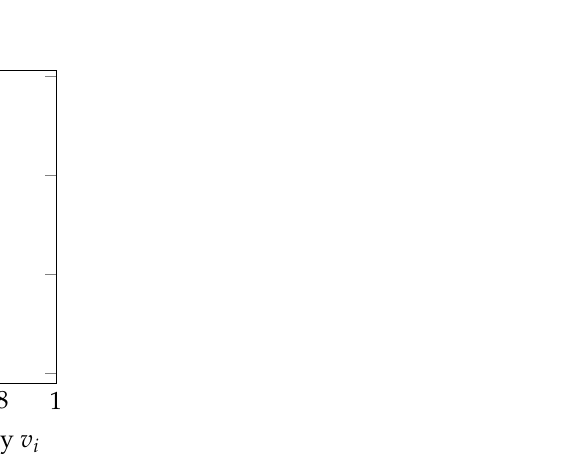
Figure 24. Sensitivity to branches’ vulnerability under limited liability with